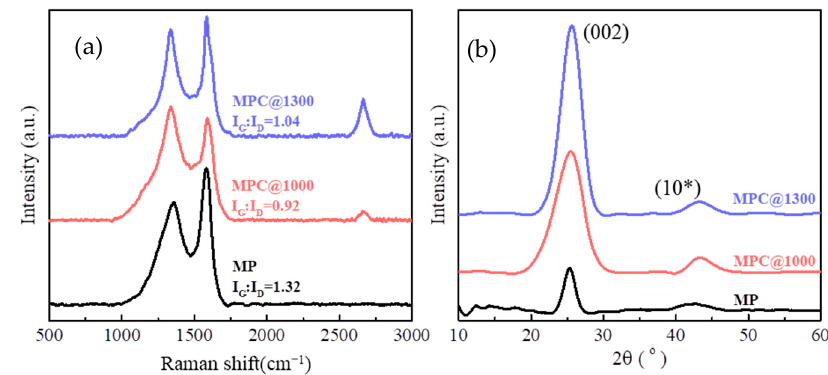
Figure 5. ( a ) Raman spectra and ( b ) XRD spectra of MP, MPC@1000, and MPC@1300.